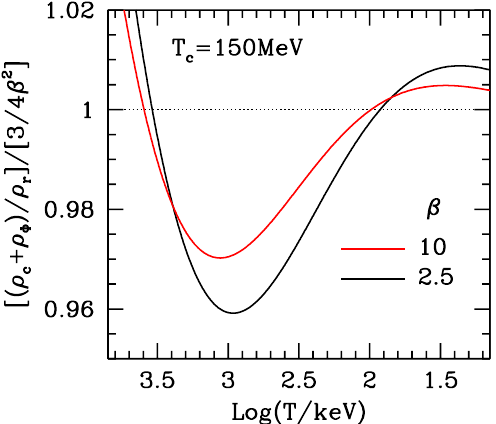
Figure 8. Magnification of the lower plots in previous figures for the region of BBN, with T (instead of a ) as ascissa. The second minimum, as also shown in the previous Figure, occurs at T ∼ 900keV, quite close to neutrino decoupling. The scale dependence of the radiative component between neutrino decoupling and the region of early 2 H synthesis undergoes a further deviation from radiative expansion, up to O ( 0.5% ) , due to electron–positron annihilation. Such deviation depends on β being stronger when the coupled DM- Φ component is